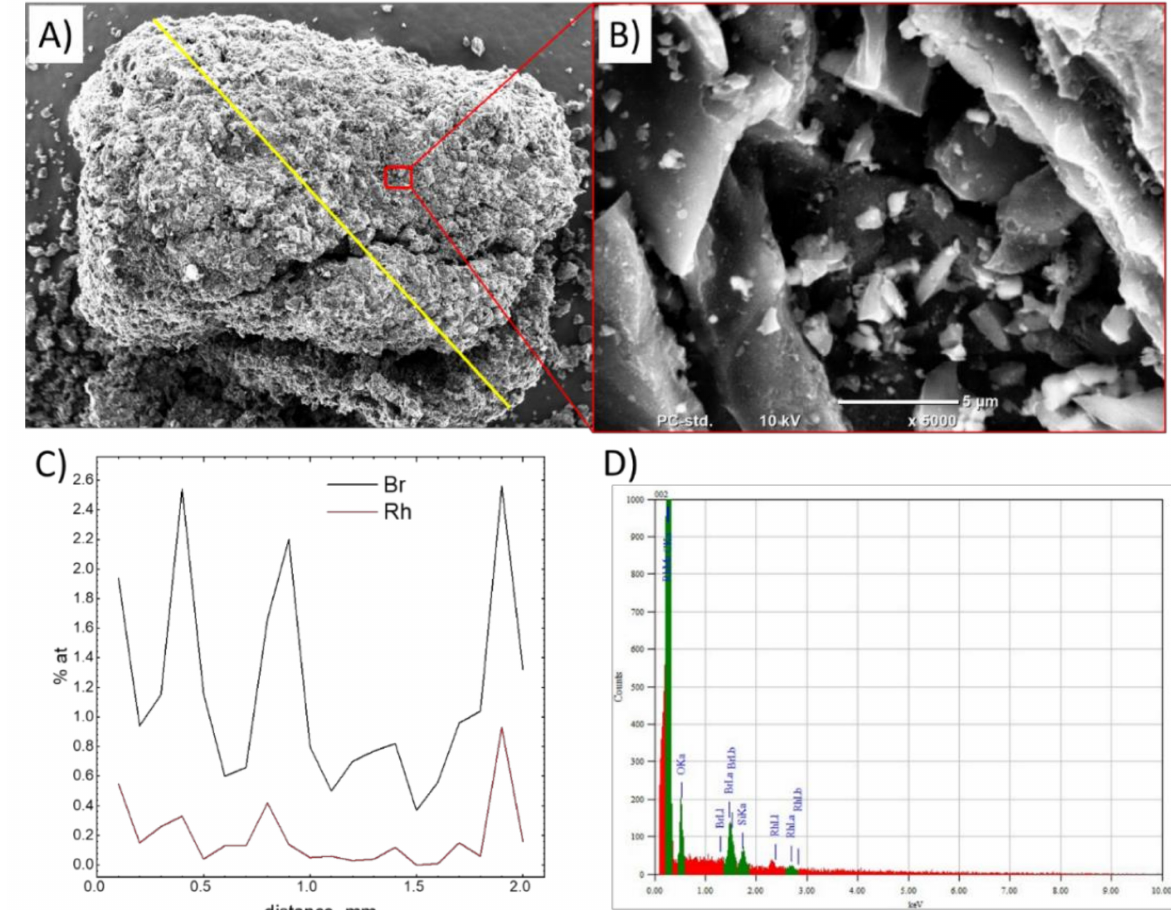
Figure 14. SEM image of the sample of activated carbon after adsorption test ( A ) general view indicating the line where EDS analysis was conducted, ( B ) magnification of the area where EDS point analysis was performed, ( C ) EDS line analysis results, ( D ) EDS spectrum for a selected